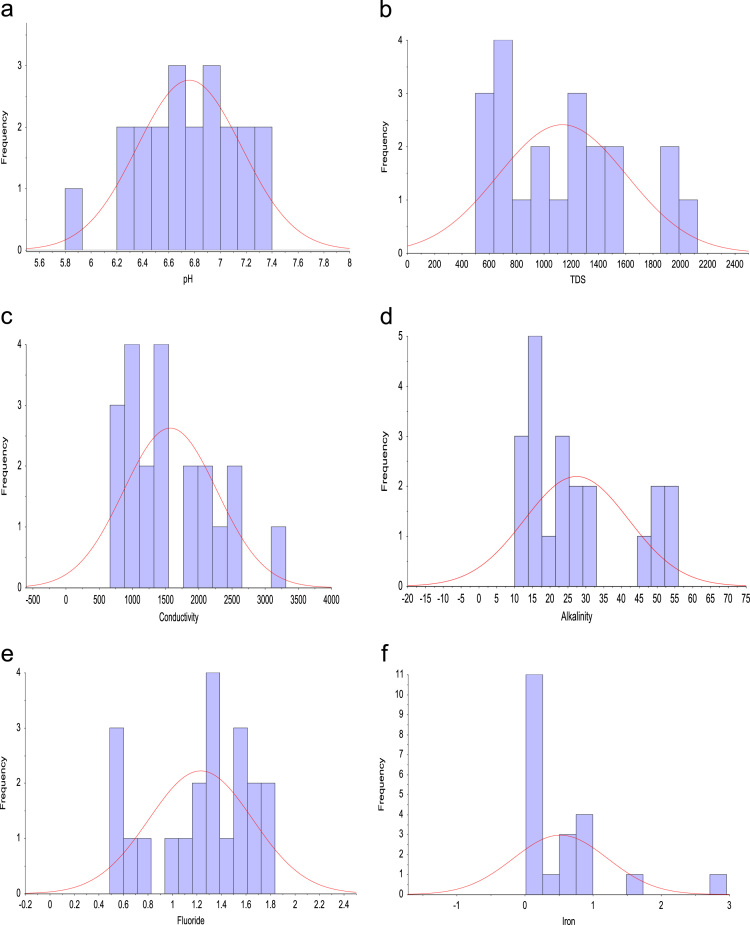
Frequency distribution of (a) pH (b) TDS (c) EC (d) Alkalinity (e) F– (f) Fe2+: frequency distribution of (g) Mn (h) Ca2+ (i) K+ (j) Mg2+ (k) Na+ (l) SO42−: frequency distribution of (m) Cl– (n) (l) SiO2 (o) HCO3– (p) NO3– (q) CO32− (r) Temperature.